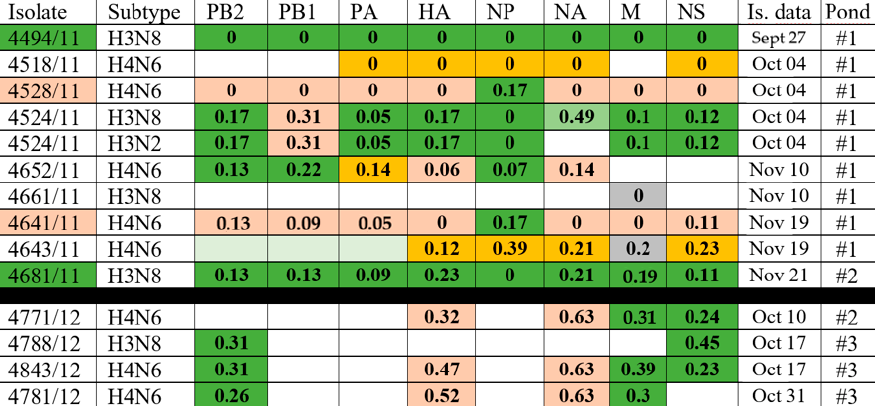
Figure 2. Examples of natural reassortment in 2011 and 2012 isolates. Gene variants that differ by more than 1% of nucleotide substitutions are marked in different colors. The numbers in the cells reflect the % of nucleotide substitutions relative to the origin isolate (cells are marked in the same color and with the number 0). The blank cells reflect the more than 1% of nucleotide substitutions relative to all the isolates of